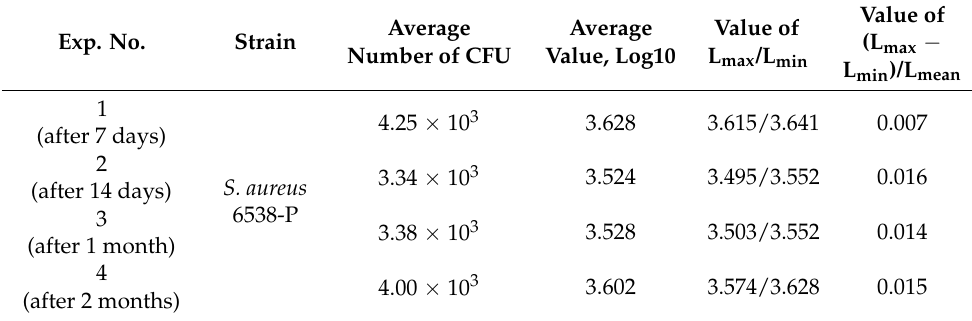
Table 7. The results of testing the validity of the experiments to assess antimicrobial activity.